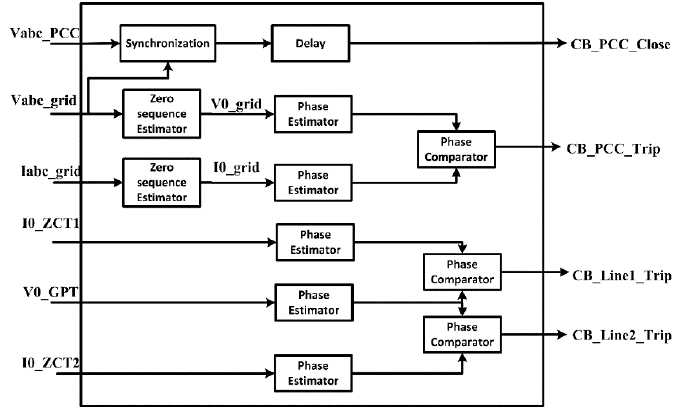
Figure 11. Block diagram of the proposed interface protection.